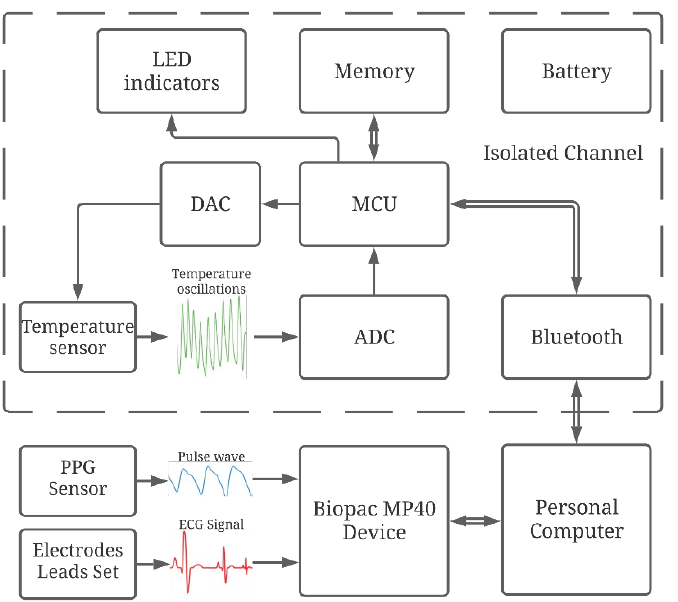
Figure 10. Structure diagram of laboratory setup with channels for synchronous recording temperature oscillations, PW and ECG signals.